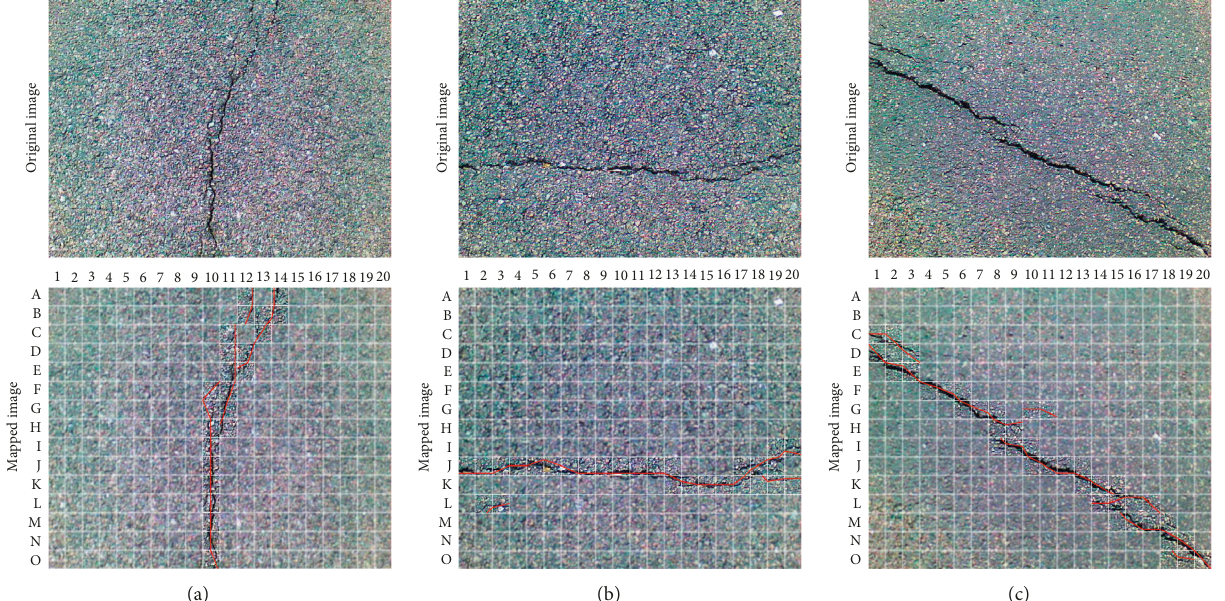
Figure 15: (a) Vertical, (b) horizontal, and (c) diagonal cracks used to test the crack mapping algorithm.